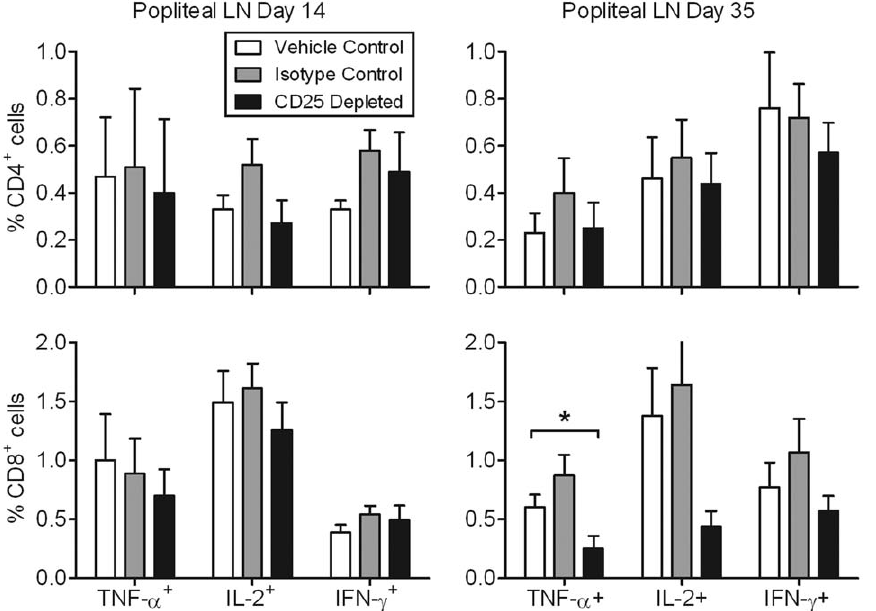
Figure 6. Cytokine-expressing CD8 + T cell levels are lower after anti-CD25 mAb treatment on day 35 post-FIV infection. Popliteal lymph node cells were incubated with monensin for 6 hours prior to quantification of cytokine expressing cells. Percent TNF- a -, IL-2-, and IFN- c - expressing cells in CD4 + and CD8 + T cell populations were quantified by flow cytometry (n=8/group). Mean 6 SEM is shown. * indicates p , 0.05.